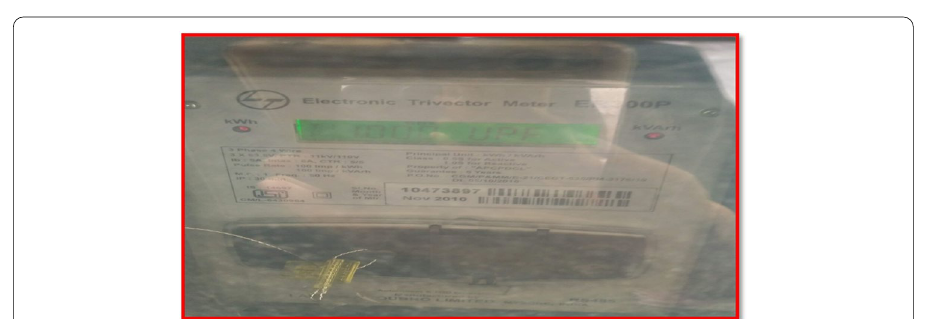
substation in this period is 0.9955 lagging. From the above data due to low power fac- tor, the excess amount paid to TSSPDCL is Rs. 16,108 during 2020. The kWh and kVAh graphs are shown in Fig. 24. From CY 2014 to CY 2020, excess energy charges paid to TSSPDCL due to low power factor at SUES Substation is shown in Fig. 25.